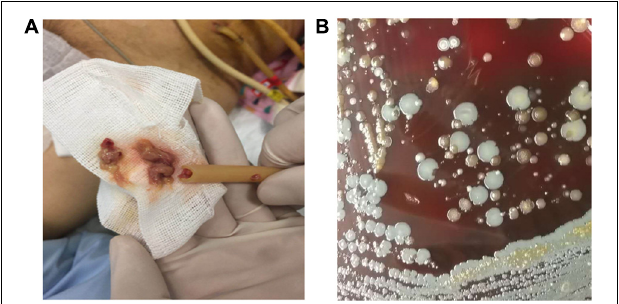
FIGURE 2 | Peritoneal dialysis catheter-associated infections caused by mixed-species biofilm. (A) The peritoneal dialysis catheter was filled with thick pus. (B) Several bacterial species derived from catheter-infection pus were grown on sheep blood agar after being cultured at 37 ◦ C for 16 h